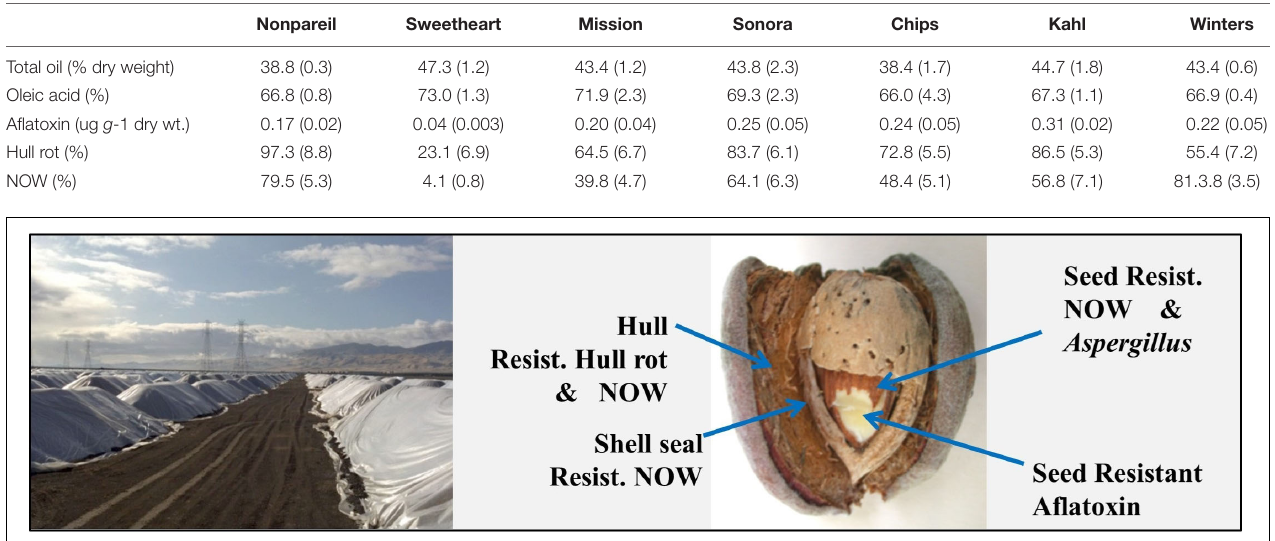
Frontiers in Plant Science |